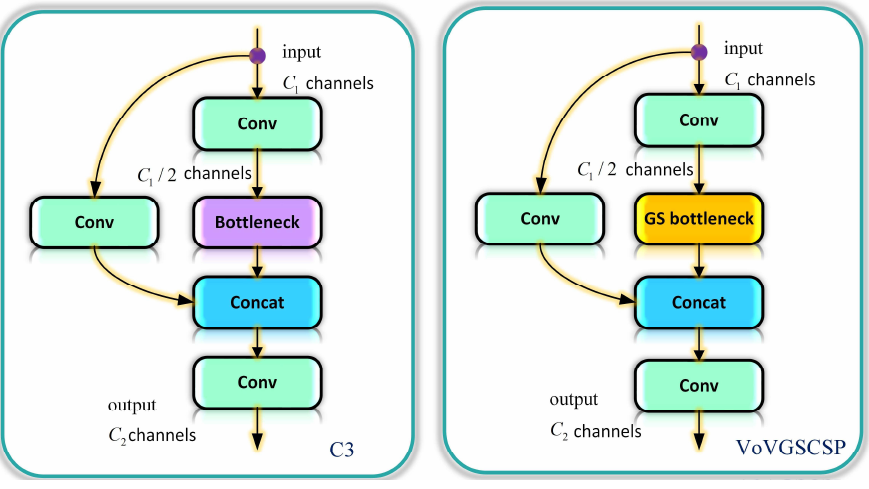
Figure 7. Structure of C3 and VoVGSCSP.